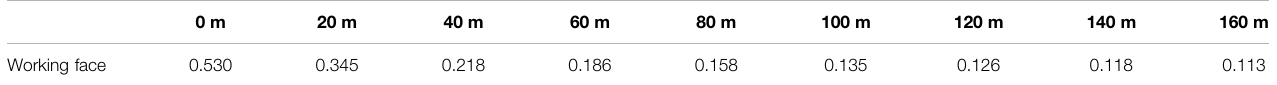
TABLE 3 | Statistical table of attenuation rate of overpressure peak at every 20 m in working face.